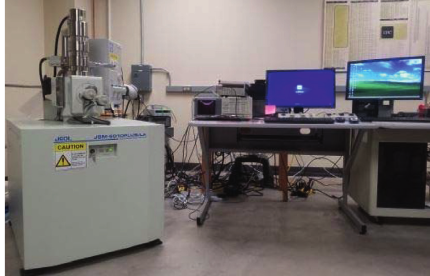
Figure 5: Environmental electron scanning microscopy